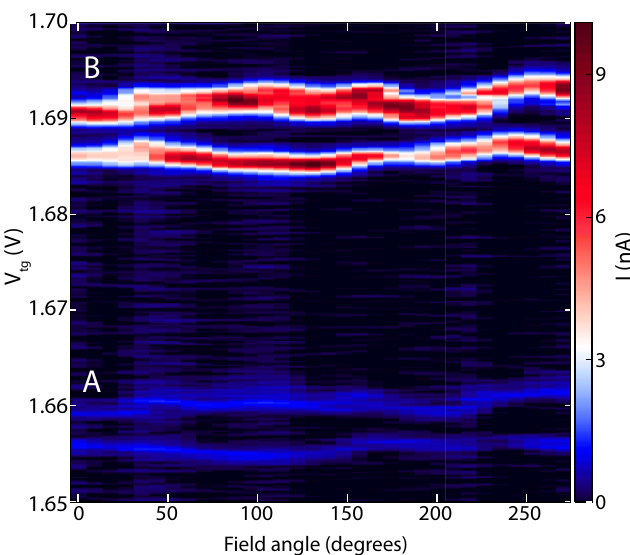
Figure S6: Device 2. Two lowest resolved electron QD states A and B as a function of topgate and magnetic field angle. State A is on the bottom, state B is on top of the = 0.1mV, global backgate voltage is zero. figure. B = 1T, V bias